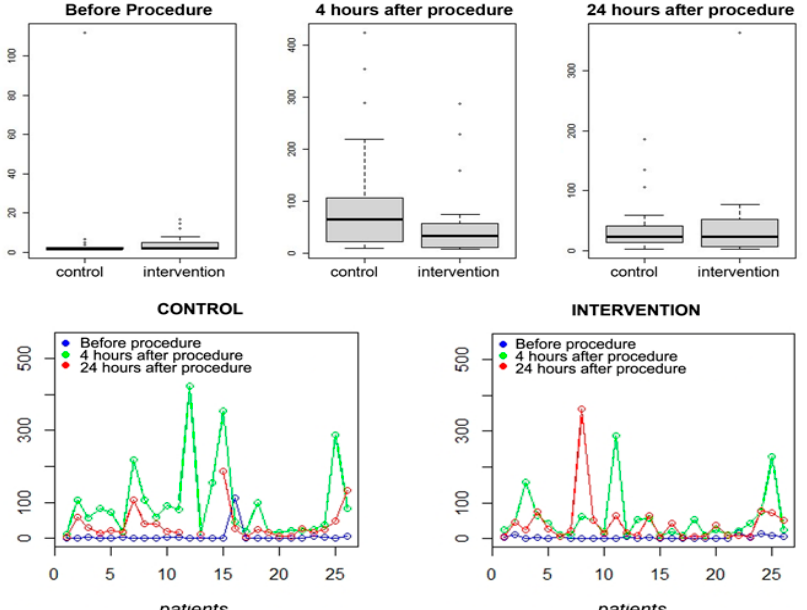
Figure 2. Boxplots and Graphs from the variable IL-6. Note that the median, represented by the central line of each boxplot, at four to six hours after surgery, showed more distant values between the control and intervention groups than for the other periods recorded. At the 5% significance level, there was a statistical difference between the groups. Graphs: values observed by each patient for IL-6 measurement time between groups.